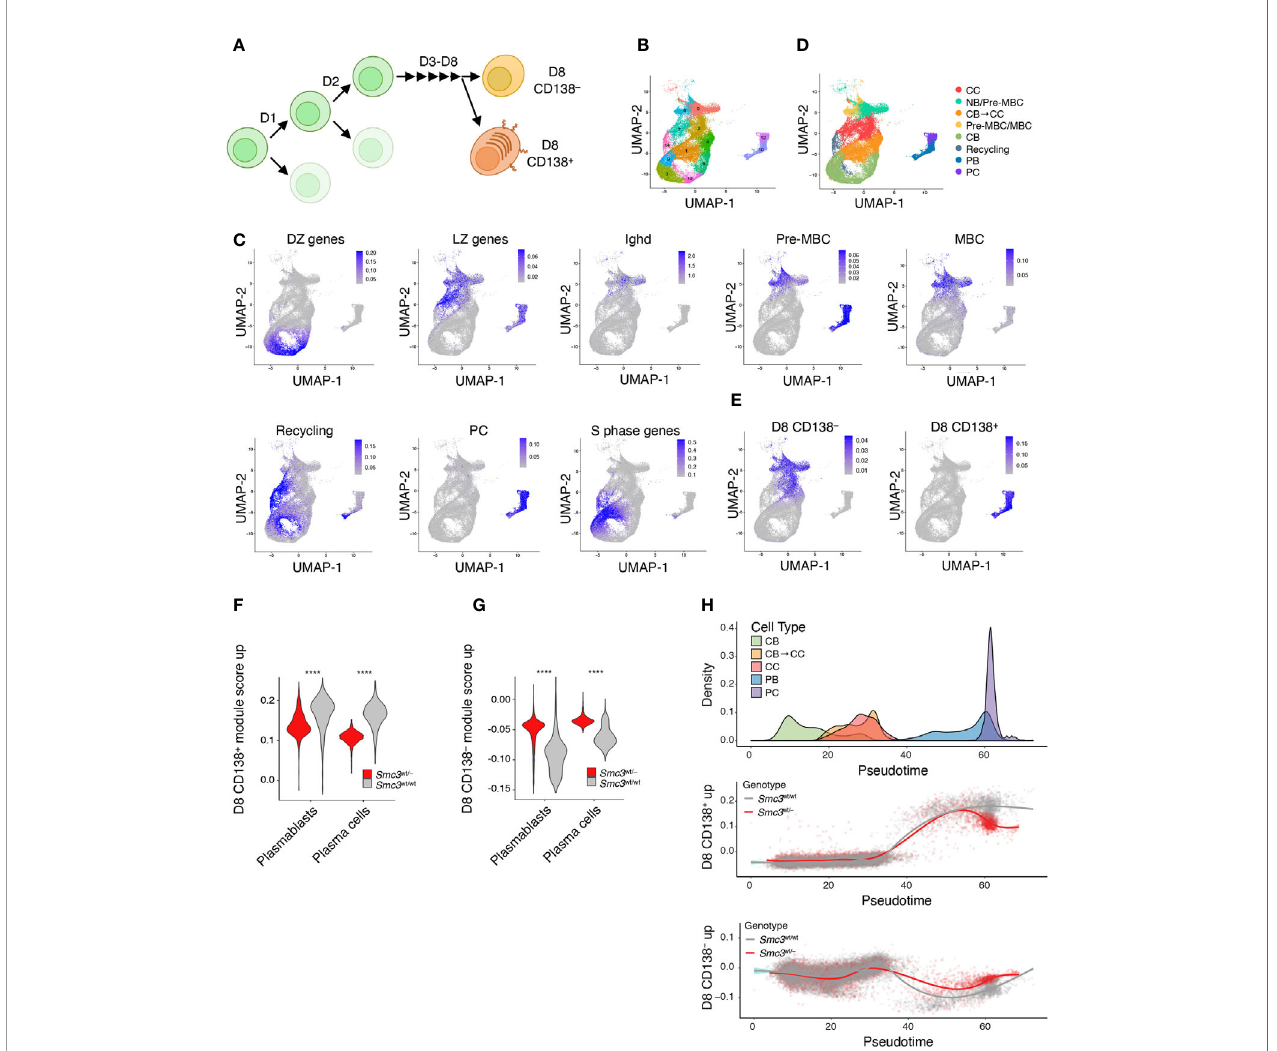
FIGURE 3 | Smc3 haploinsuf fi cient cells undergo proliferation burst but fail to differentiate into plasma cells. (A) Scheme depicting mature B cell differentiation leading to the plasma cell phenotype. (B) Uniform Manifold Approximation and Projection (UMAP) applied to single cell RNA-seq populations of germinal center and post germinal center populations. (C) UMAP projections of gene expression cell signatures used to classify clusters. (D) Applying previously de fi ned gene expression signatures, Seurat clusters were manually de fi ned as centrocyte (CC), pre-memory B cells (Pre-MBC), transitioning centroblast to centrocyte (CB ! CC), transitioning centrocyte to centroblast (Recycling), memory B cells (MBC), plasmablast (PB), and plasma cells (PC). (E) UMAP showing the projections of in vivo LPS-stimulated CFSE stained B cells that divided 8 times expressing CD138 (D8 CD138 + ) or not (D8 CD138 – ). (F) Violin plots showing expression levels of D8 CD138 + for PB and PC clusters. (G) Violin plots showing expression levels of D8 CD138 – for PB and PC clusters. (H) Cell densities for pseudotime lineage (CB ! CB to CC ! CC ! PB ! PC, top plot) and scatter plots of cells by genotype across pseudotime lineage expressing D8 CD138 + (middle panel) or D8 CD138 – (lower panel) pro fi les. ****p <